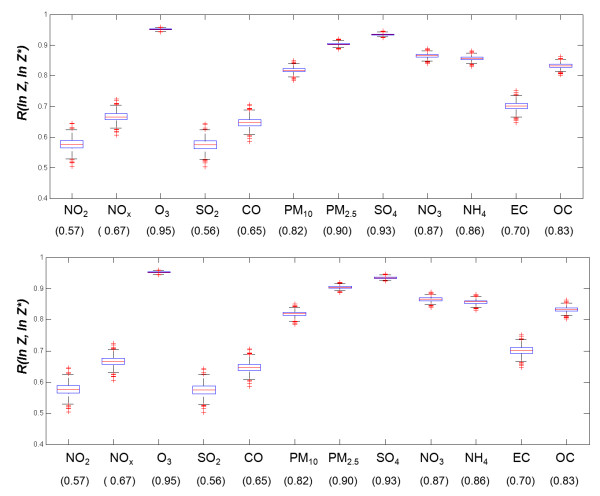
Boxplots of R(InZ, InZ*), with expected correlation coefficients shown in parentheses for 1000 simulated data time-series of error type C (top panel) and type B (bottom panel) simulations.